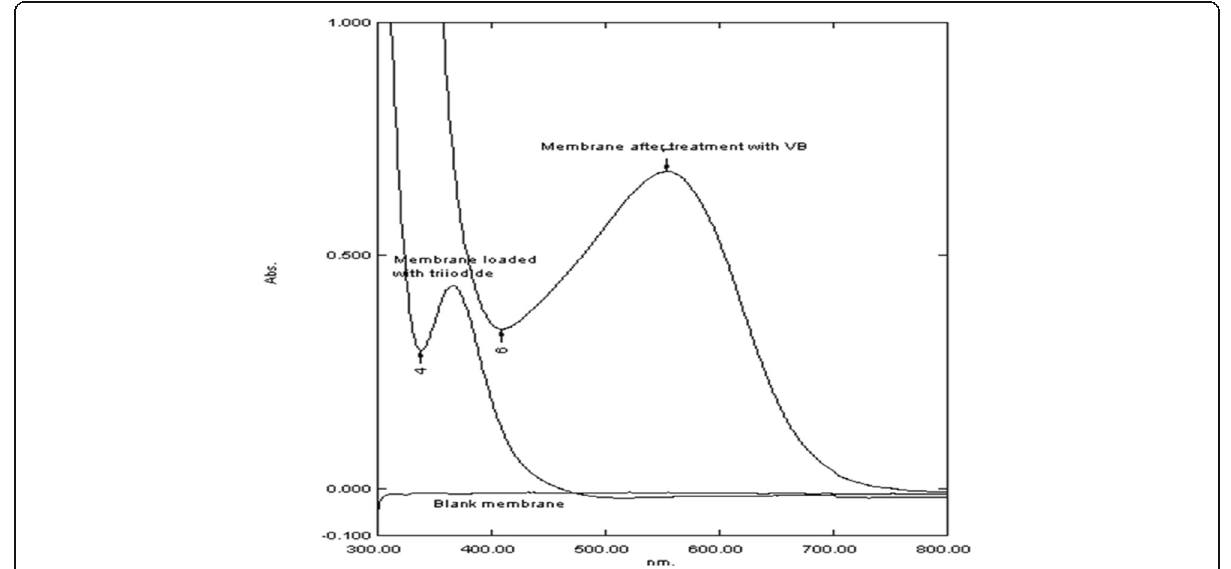
Fig. 1 UV-Visible spectrum of the films a Blank film. b . I 3 − sorbed film. c variamine blue dye-treated film